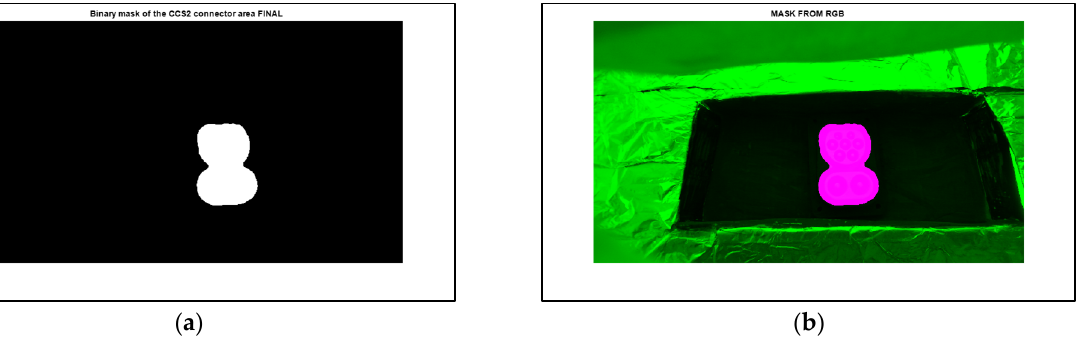
Figure 7. ( a ) The binary mask of the CCS2 socket and ( b ) overlapped image of the RGB image with the binary mask of the CCS2 socket.